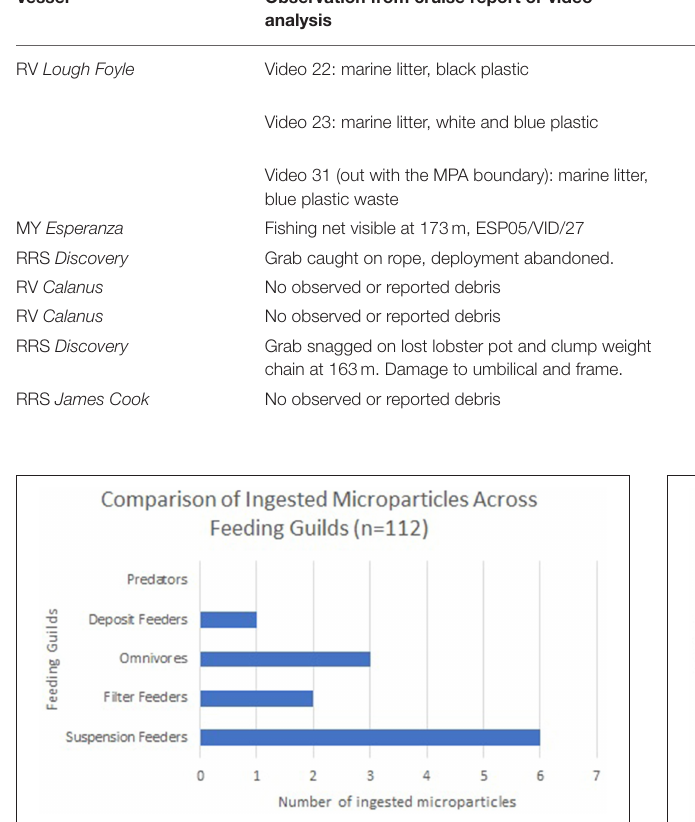
TABLE 3 | Categories of marine litter observed from video footage or reported in cruise reports from the East Mingulay MPA and an adjacent area. Vessel